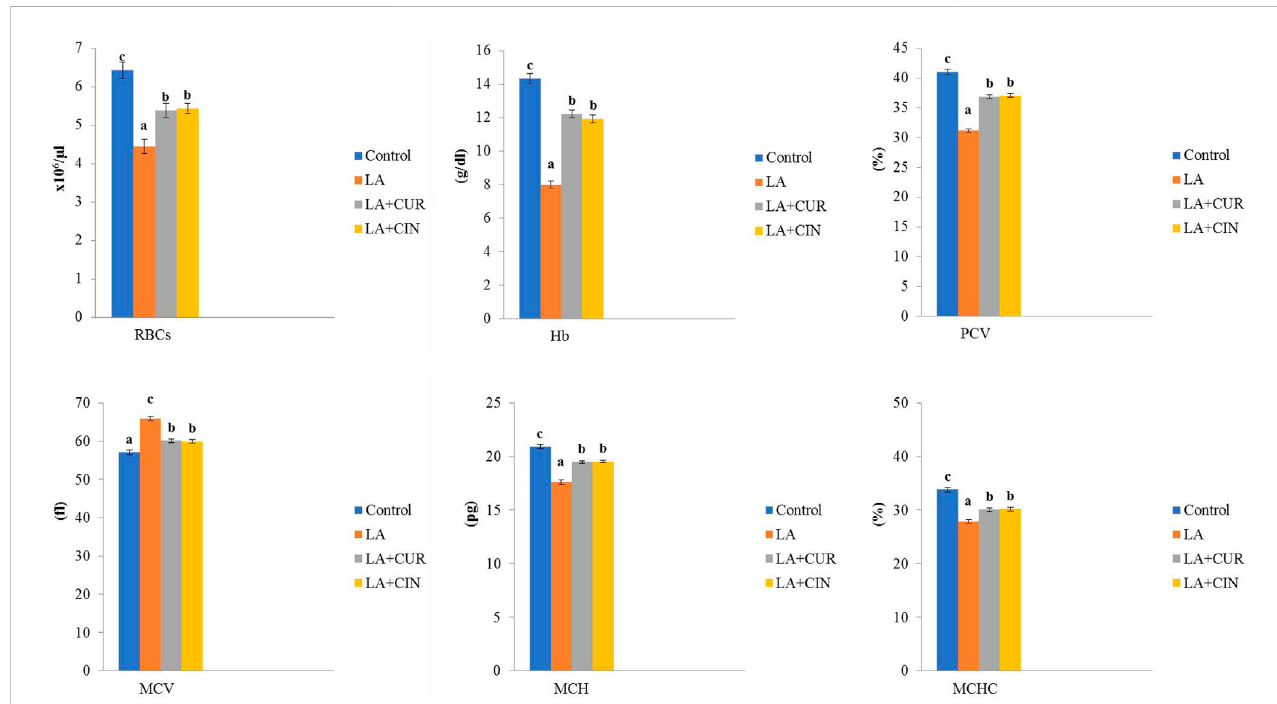
FIGURE 1 Changes of erythrogram in different treatment groups compared to the control (mean ± SE). Different superscript letters in each fi gure indicate signi fi cant differences at p <